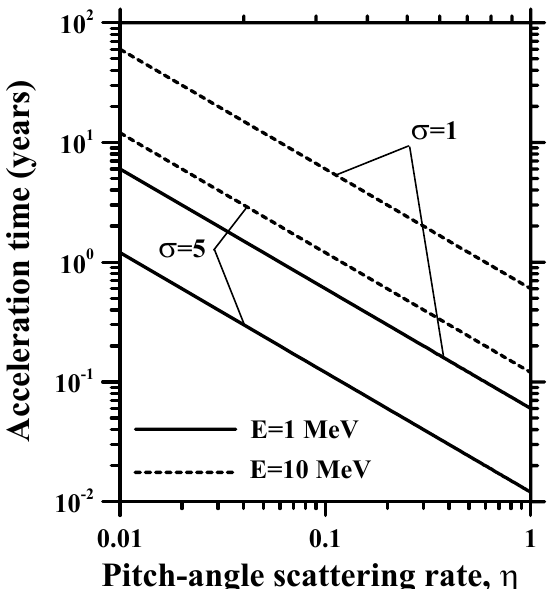
Fig. 3. Acceleration time for 1MeV (solid lines) and 10MeV (dashed lines) energies as a function of the pitch-angle scattering rate for different values of σ